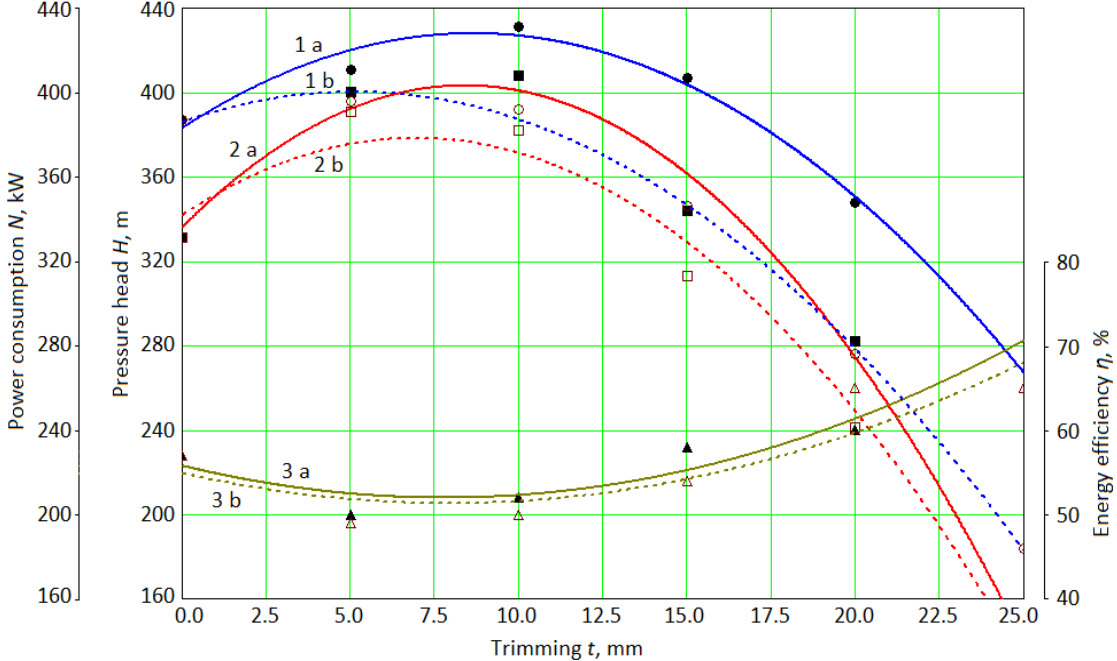
Figure 9. Pressure and energy characteristics for various trimming values: 1—pressure head, m; 2—power consumption, kW; 3—energy efficiency, %; a—the elongated counter-rotating stage ( D 4 = const); b—the replaced counter-rotating stage ( h = const).